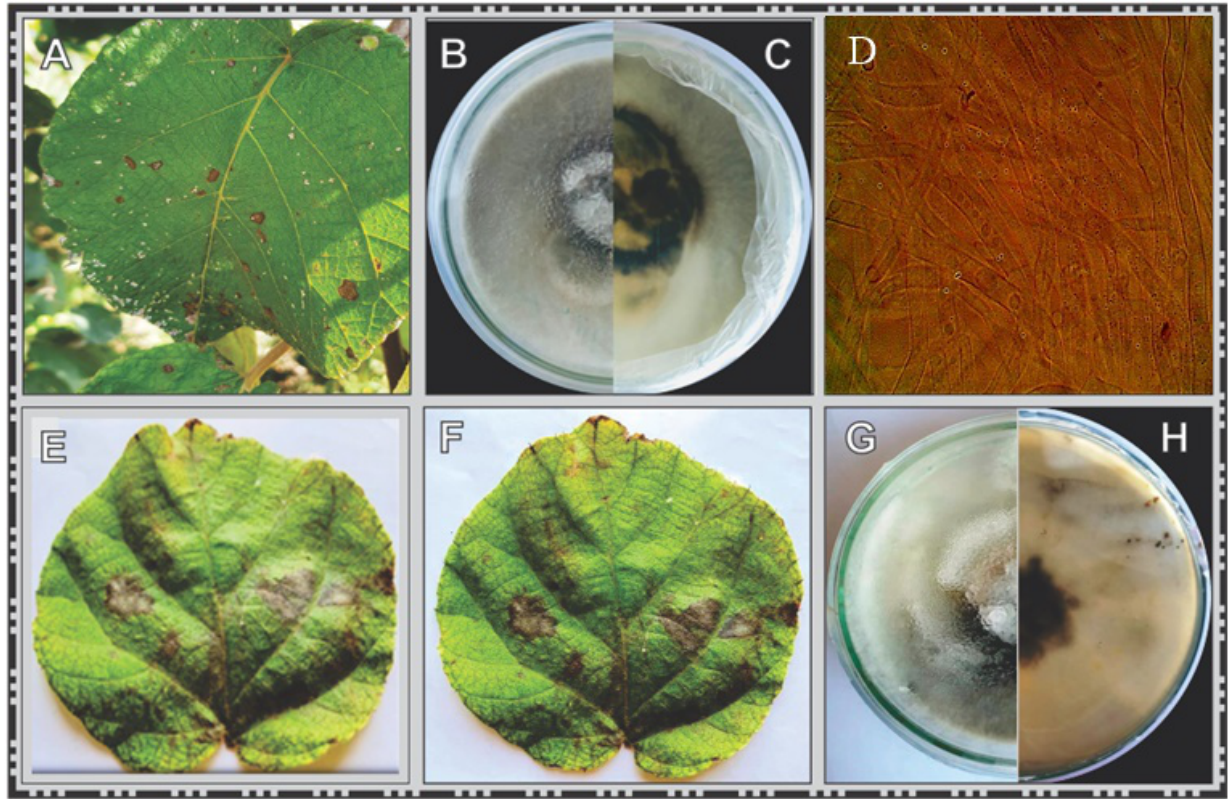
Figure 2. Leaf spots were observed on the leaves of Kiwi ( A ). The disease-causing fungus was grown in petri dishes and examined from the front side ( B ) and back side ( C ). Microscopic examination was done at 40 × magnification ( D ). Healthy leaves were inoculated, and disease symptoms were examined after 3 days ( E ) and 5 days ( F ) of inoculation. The fungus was re-isolated and examined from the front ( G ) and back ( H ) sides of the petri